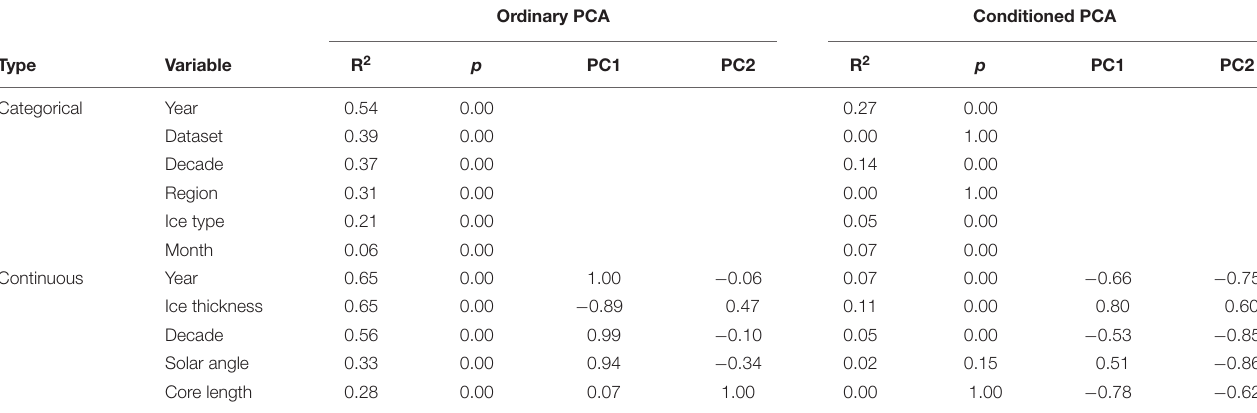
TABLE 4 | Overview of explanatory variable fit to the Principal Component Analysis (PCA) ordinations in Figure 5 and Supplementary Figure S2 . Ordinary